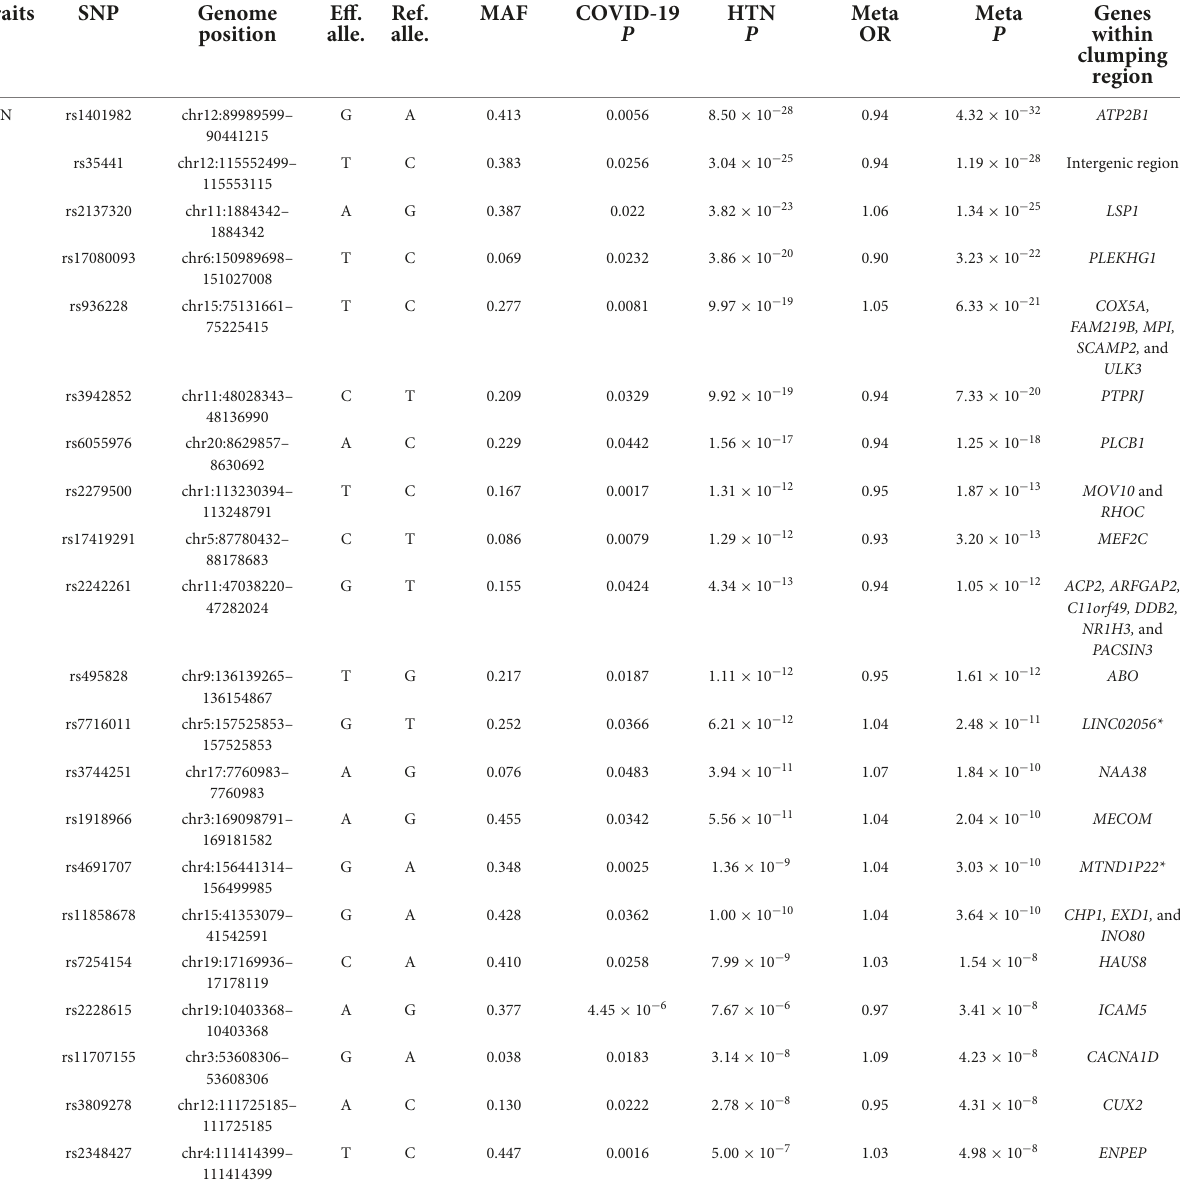
Eff. Ref. MAF COVID-19 alle. alle.